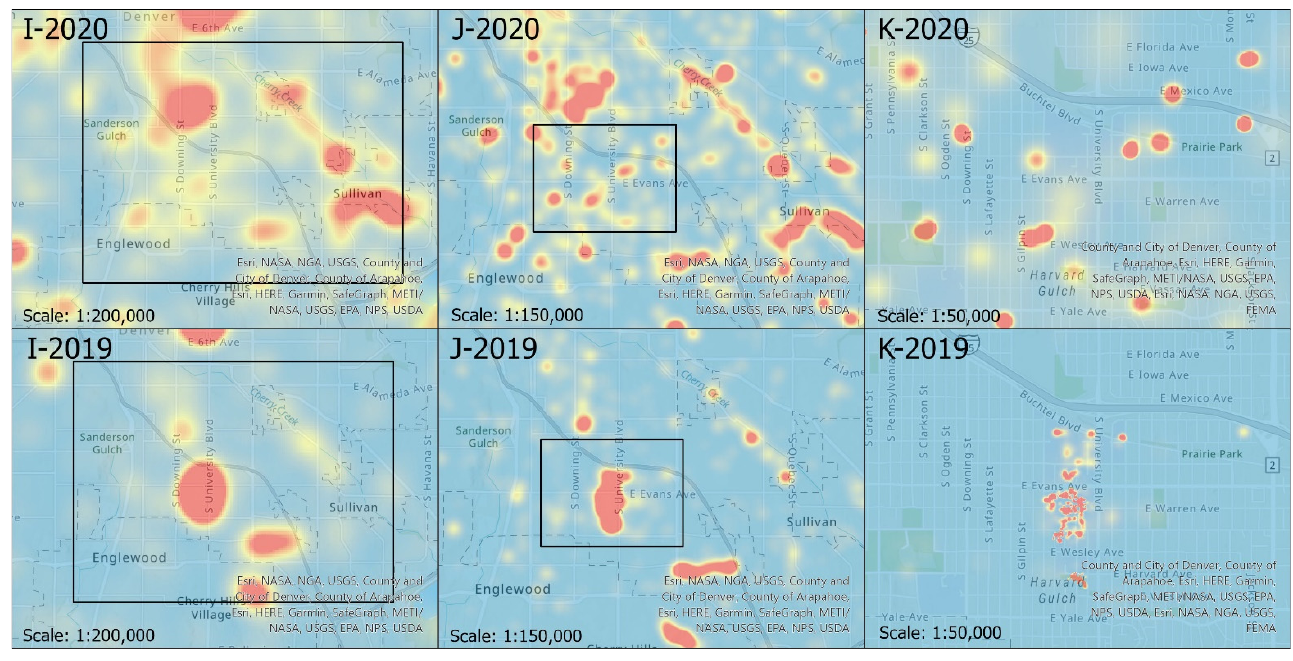
Figure 4. Changes in observation hot-spots across 2019 and 2020 on the University of Denver campus. ( I – K ) corresponds to the increasingly large map scales at which hot-spots are detected and visualized.